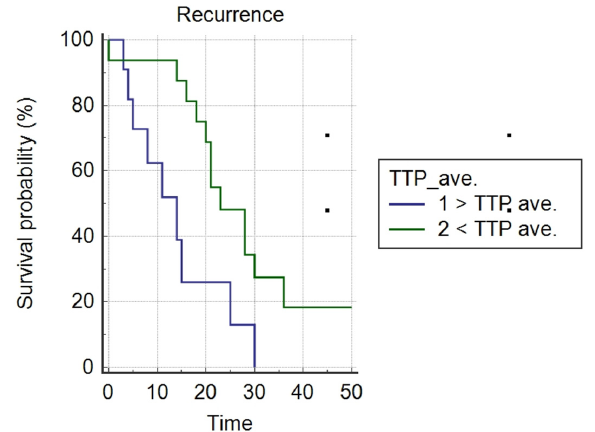
Figure 11. Kaplan–Meier (log rank) analysis of PFS for values below and above the median Perf. TTP; ns ( A ), Perf. Max. En.; ns ( B ) and ADC, p = 0.046 ( C ).